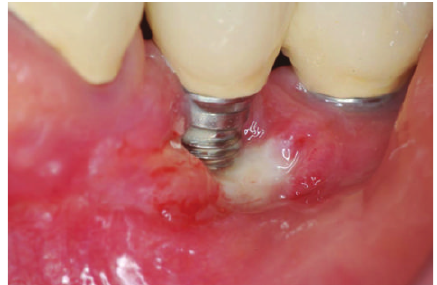
Figure 19: Postoperative aspect 14 days after surgery.